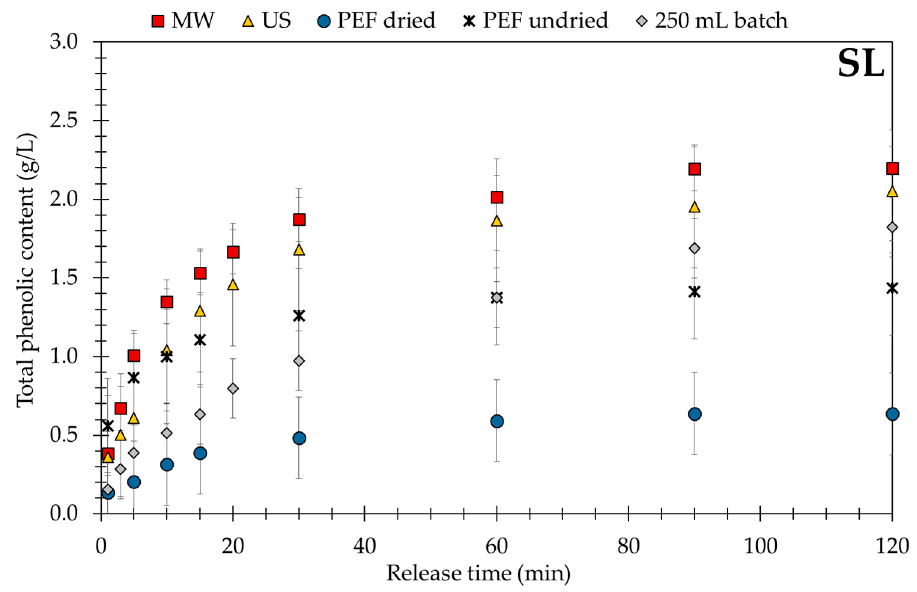
Figure 6. Extraction kinetics using alternative processing techniques and large sample size (SL).